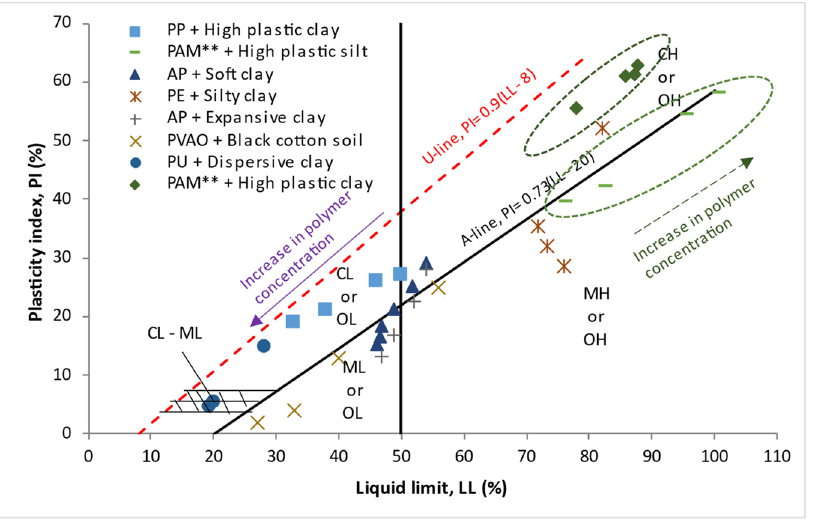
Figure 3. Plasticity chart of soil treated with polymer (** indicates polymer concentration as a % of weight of water). Note: this figure was created with data obtained from [65,102,108,141–143,145,147].